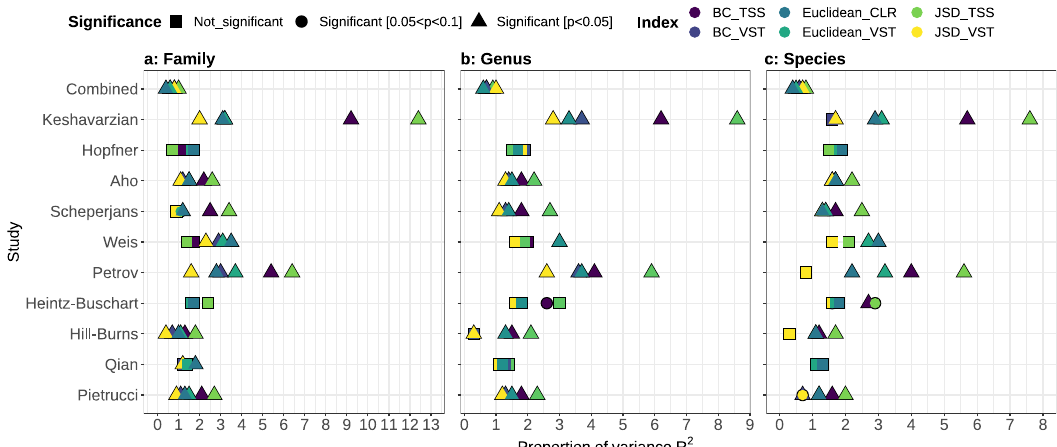
Fig. 3 The gut microbiome structure differs signi fi cantly between PD patients and controls. Data were normalized using three independent approaches (VST variance stabilizing transformation, TSS total sum scaling, CLR centered log-ratio) and beta-diversity was estimated using three indices (Bray – Curtis, BC; Jensen – Shannon divergence, JSD; Euclidean). The effect of the disease status on the clustering of the data was assessed using a permutational analysis of variance (PERMANOVA). In the majority of the studies and approaches considered, and across all taxonomic ranks ( a , b , c ), the gut microbiome of PD patients resulted signi fi cantly different from the one of controls. The disease status explains only a small fraction of the data variability (<13% R 2 ), indicating that other environmental factors might have a stronger role in shaping the bacterial communities. The dataset obtained by pooling all ten studies is referred to as “ Combined ” in the fi gure.